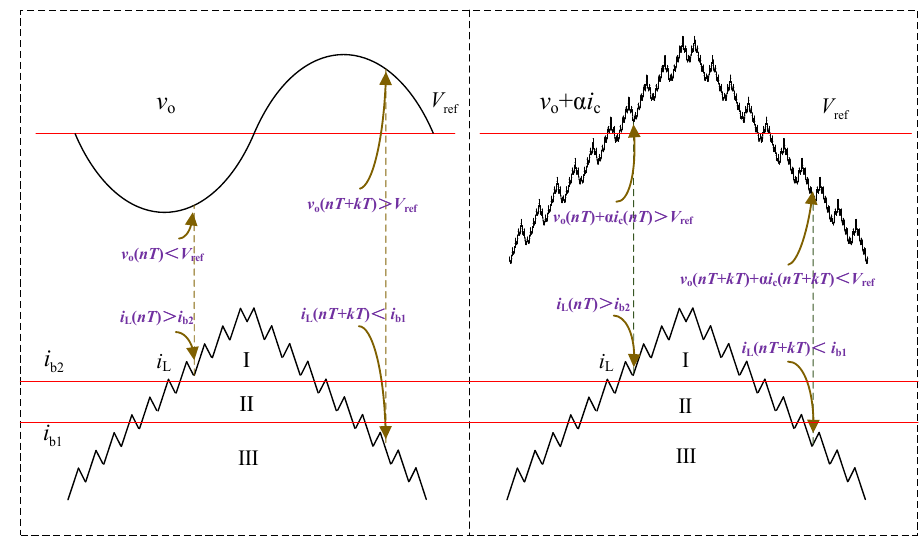
Figure 6. CC&OV-PT control to suppress low-frequency oscillations.